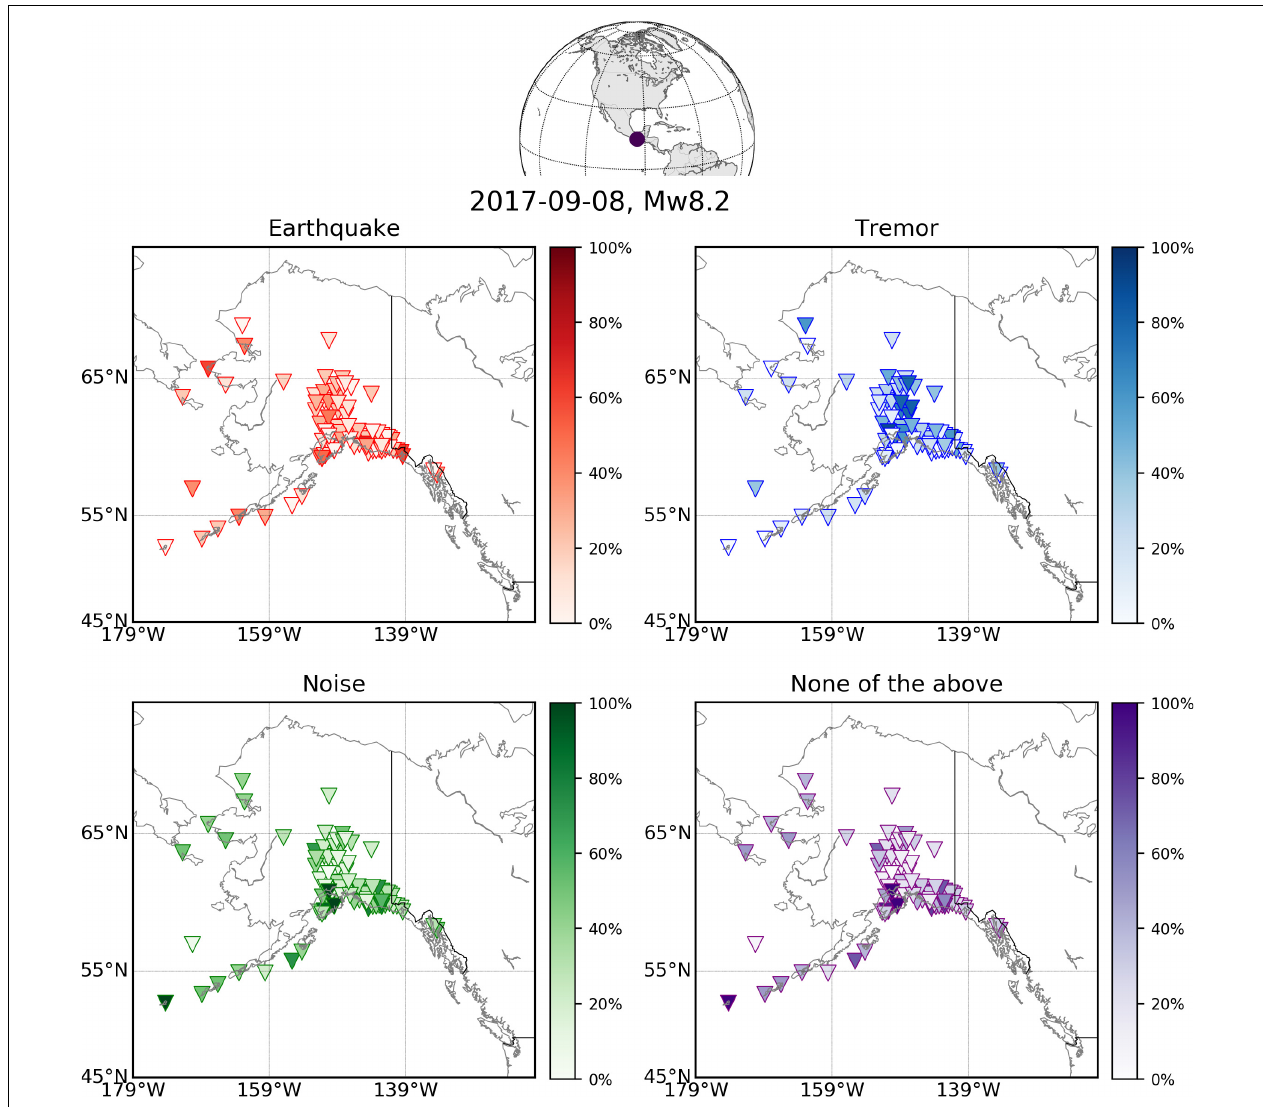
FIGURE 7 | Map of stations showing the locations of recordings of triggered tremor for different teleseismic earthquakes.